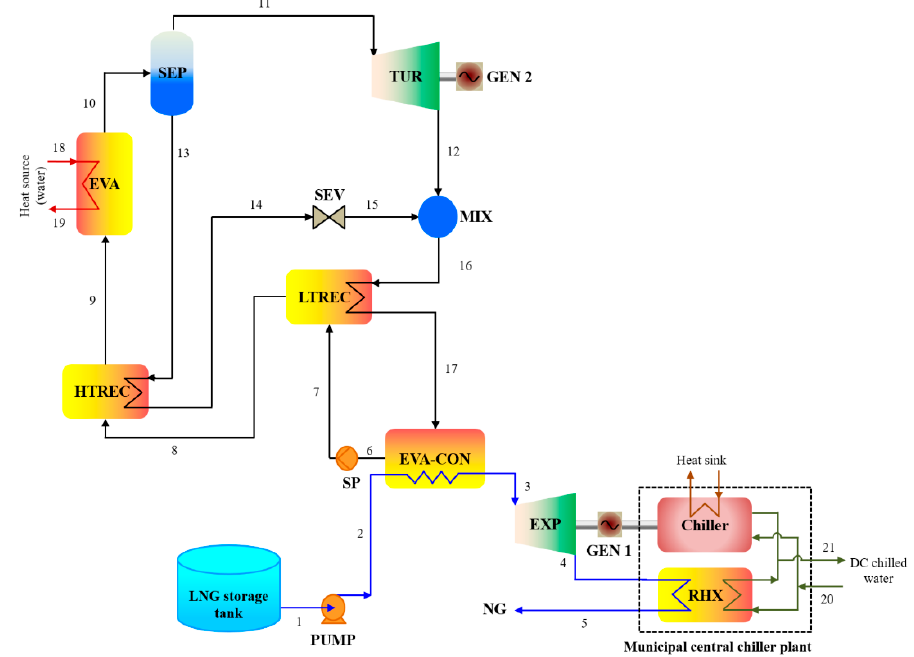
Figure 1. Schematic representation of liquefied natural gas (LNG)-assisted, Kalina cycle (KC)-based poly-generation system for municipal air-conditioning, electricity generation, and LNG vaporization. Chiller = electricity-driven vapor compression chiller; EVA = evaporator; EVA-CON = evaporator-condenser; EXP = LNG expander; GEN = electric generator; HTREC = high-temperature recuperator; LTREC = low-temperature recuperator; MIX = mixer; PUMP = LNG pump; RHX = refrigeration heat exchanger; SEP = vapor-liquid separator; SEV = solution expansion valve; SP = solution pump; TUR = KC turbine.